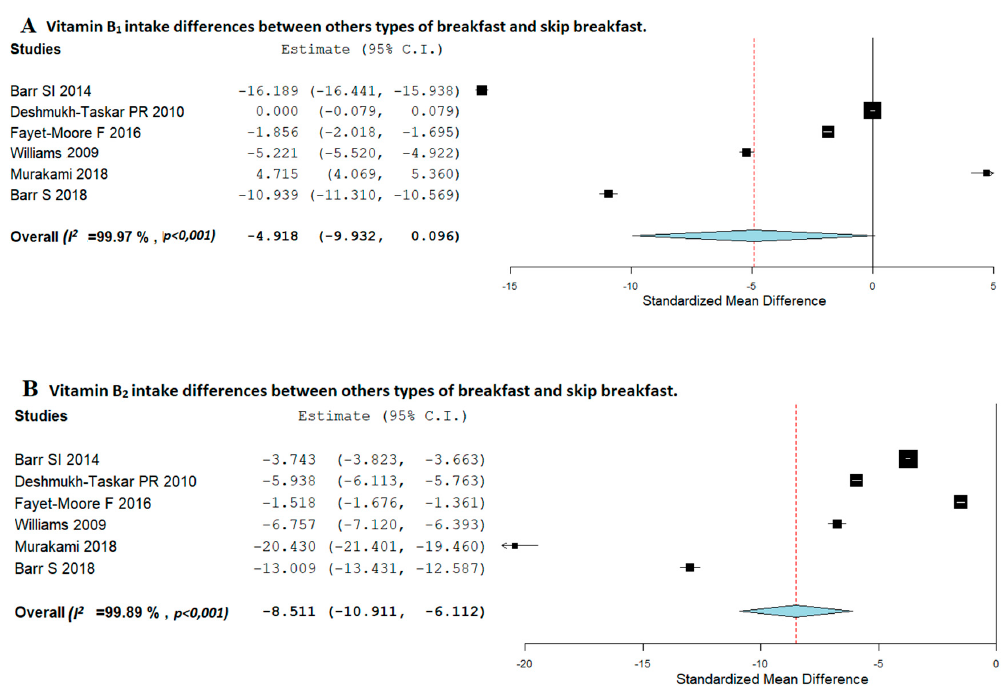
Figure 3. Random-effects meta-analysis of the effects of relationships between RTEC breakfast and breakfast-skipping concerning calcium ( A ), iron ( B ), magnesium ( C ), sodium ( D ), and potassium ( E )